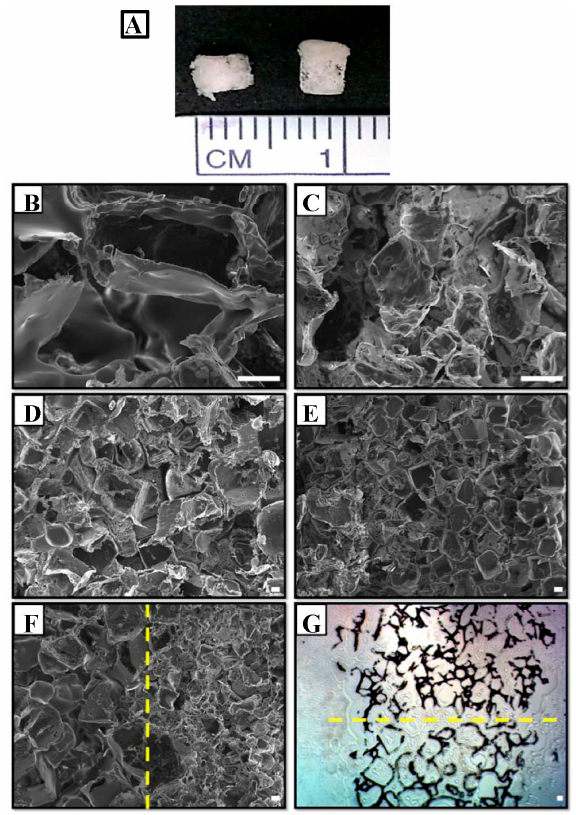
Figure 1. SEM images of bilayered porous poly (lactic-co-glycolic acid) (PLGA) scaffolds. ( A ) Macroscopic view of the scaffold. ( B – G ) Microscopic views of the scaffold: high magnification image of large pores (200×) ( B ); high magnification image of small pores (200×) ( C ); low magnification image of large pores (50×) ( D ); low magnification image of small pores (50×) ( E ); bilayered PLGA scaffold (50×) ( F ); and light micrograph of a frozen section of a bilayered PLGA scaffold ( G ). The yellow dotted line in ( F ) and ( G ) represents the boundary between the lower (large pore) and upper (small pore) layers. Scale bar: 100 μ m.